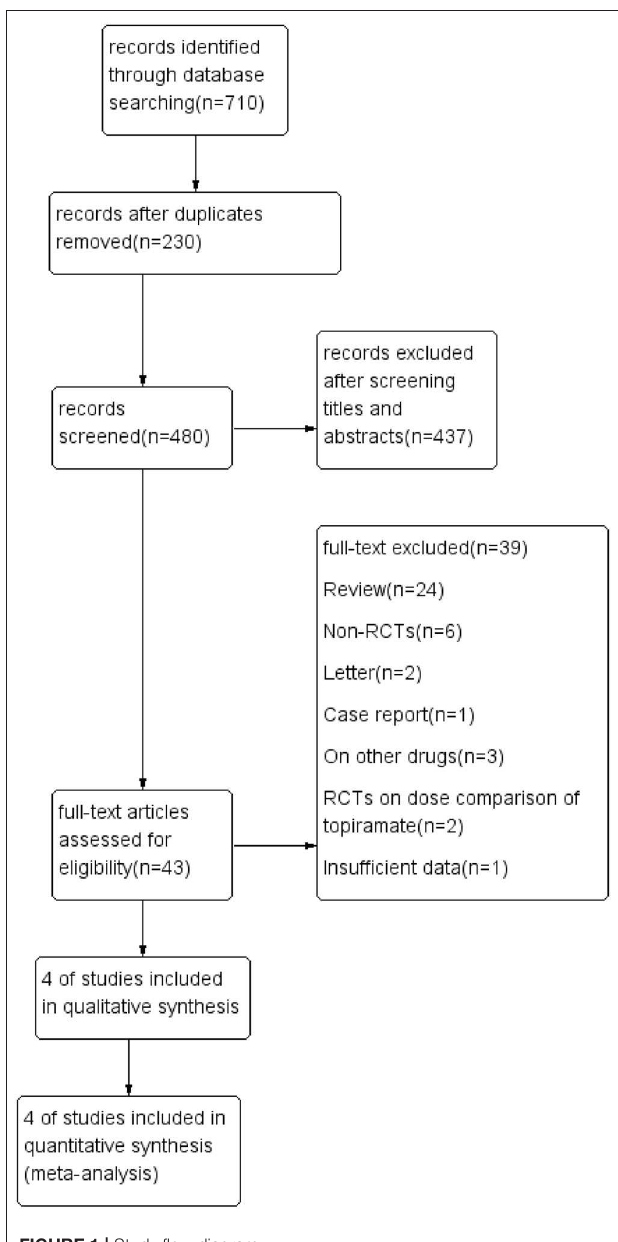
FIGURE 1 | Study flow